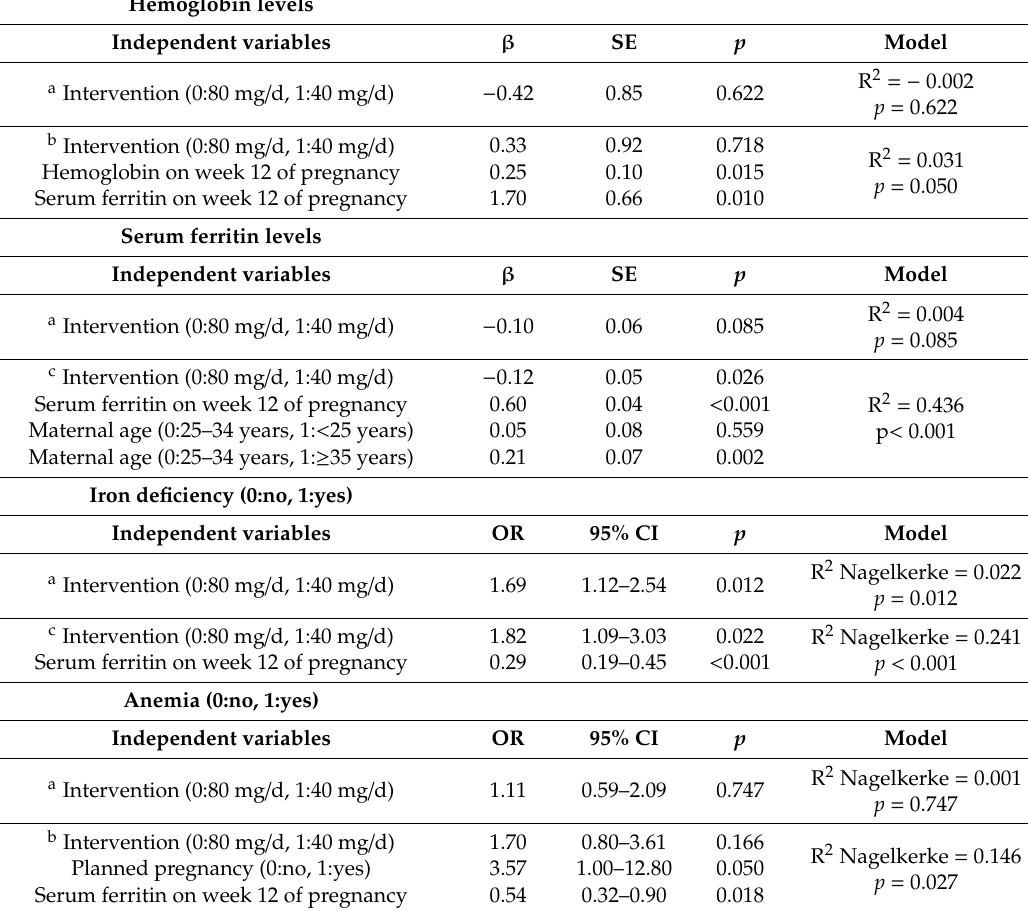
Table 3. The e ff ects of the intervention with iron supplementation (40 or 80 mg / day) throughout pregnancy on hemoglobin and serum ferritin levels and on the risk of iron deficiency (ID), anemia, iron deficiency anemia (IDA), and hemoconcentration on the third trimester in women from Stratum